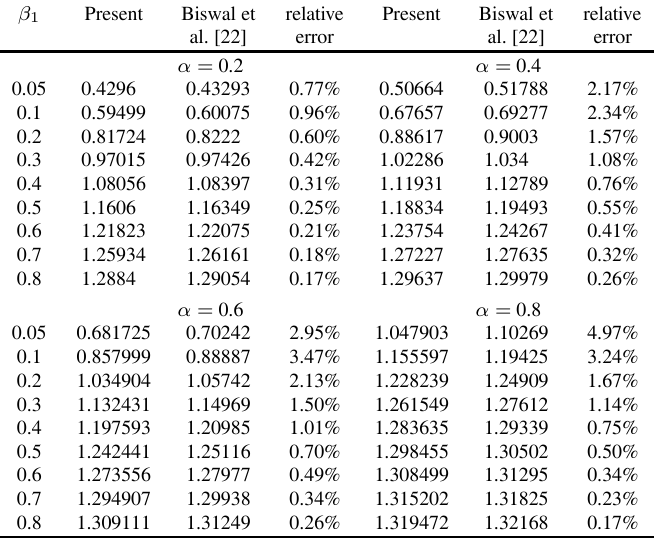
Table 3 Comparison study of Λ 11 for β =